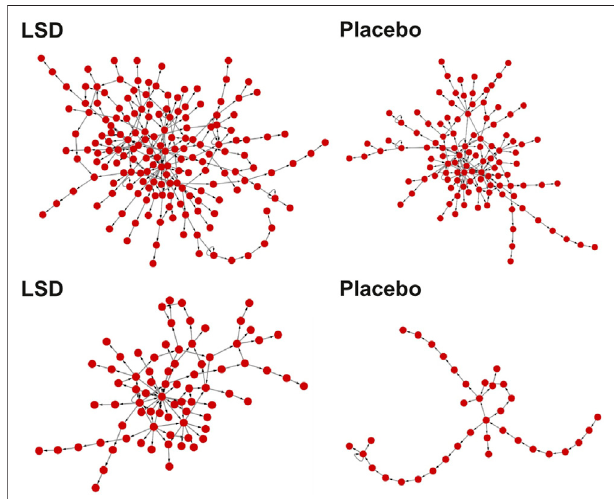
FIGURE 4 | Alterations in non-semantic features of speech produced under the acute effects of 75 μ g of LSD. Example graphs encoding speech produced under the acute effects of LSD (left) and under a placebo (right). Each node (red circles) corresponds toaword inthetranscripts, and the directed links indicate that one word (target node) followed another (source node) at least once during the speech transcript (Sanz et al.,